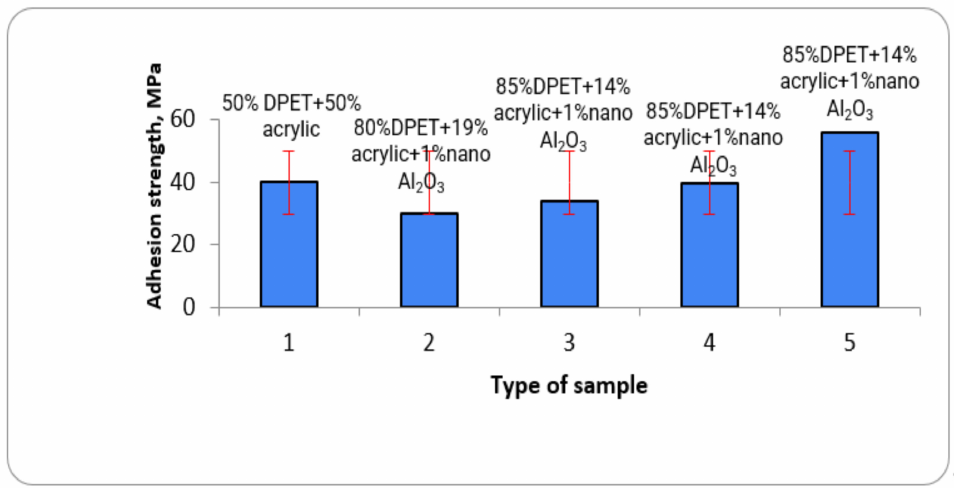
Figure 6. The adhesion coating composite strength of samples with DPET and